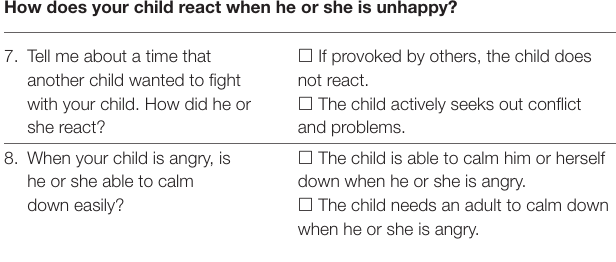
TABLE 7 | Example draft initial questionnaire item. How does your child react when he or she is unhappy?